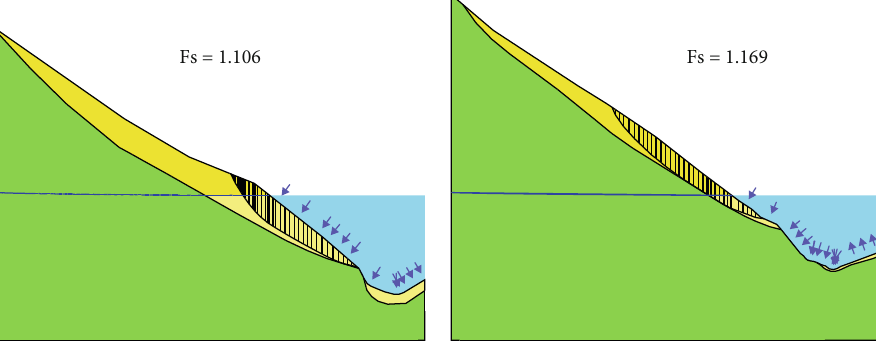
Figure 13: The shape of potential slide surface for two pro fi